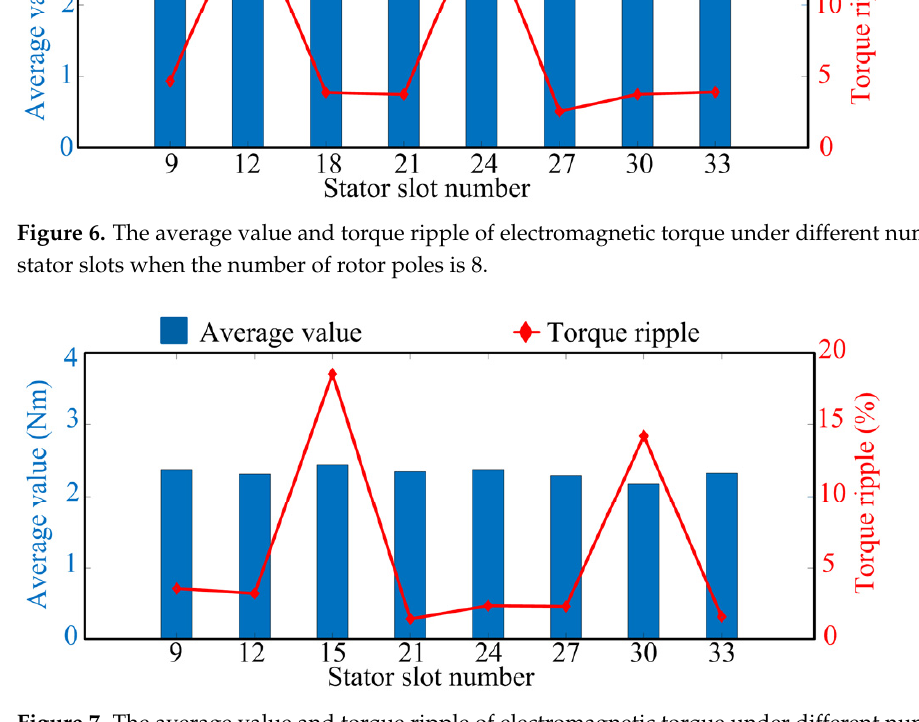
Figure 7. The average value and torque ripple of electromagnetic torque under different numbers of stator slots when the number of rotor poles is 10.